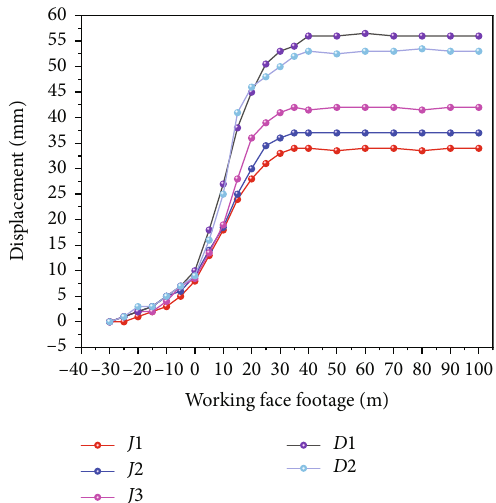
Figure 13: Displacement curve of the roadway surface.